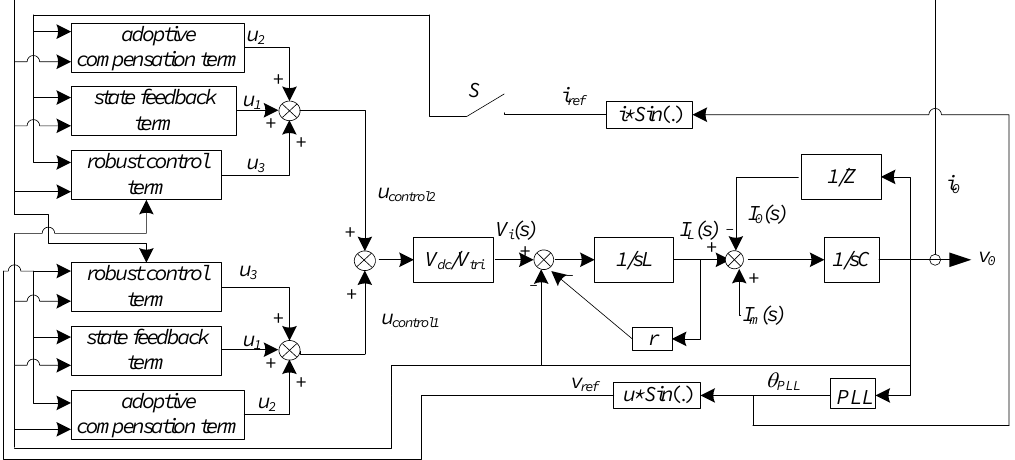
Figure 5. Block diagram of the MSC model and its